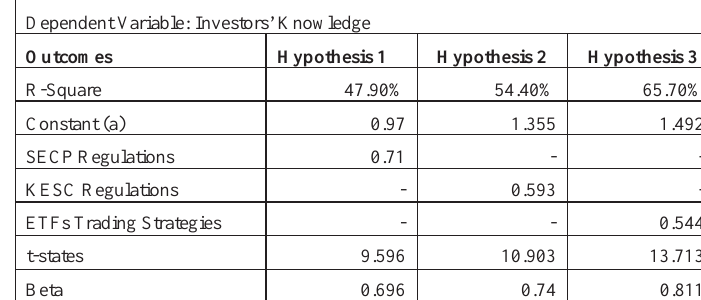
Table 5: Inferential Analysis